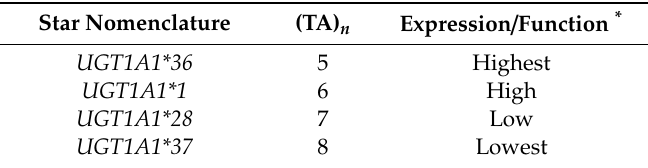
Table 1. Nomenclature and expression